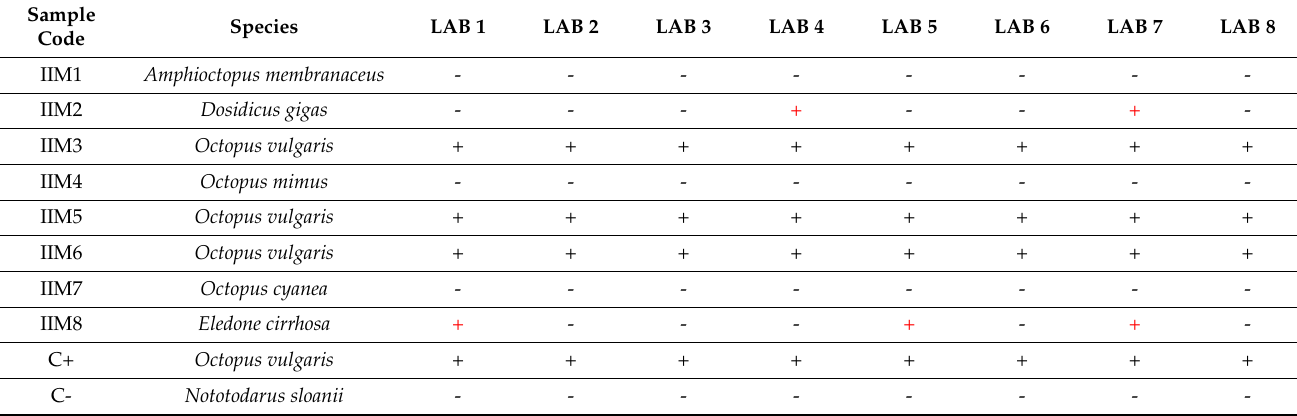
Table 4. Interlaboratory validation results. The table shows the species in the samples and the result achieved by the RPA-LFA test. Control positive (C+) and control negative (C–), to check the specificity of the reaction, were also included. Sample